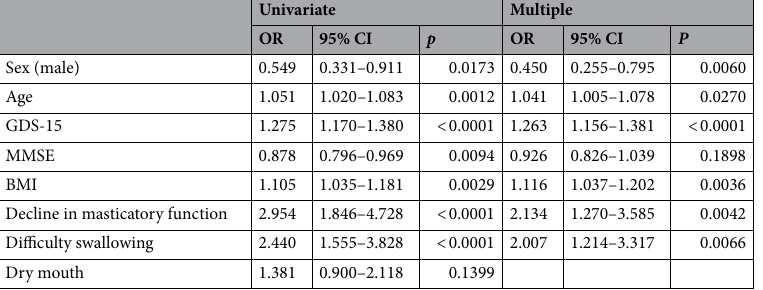
Table 2. Odds ratios of characteristics for LS. Univariate and multiple logistic regression analyses were performed. LS locomotive syndrome; OR odds ratio; CI confidence interval; GDS-15 Geriatric Depression Scale; MMSE Mini-Mental State Examination; BMI body mass